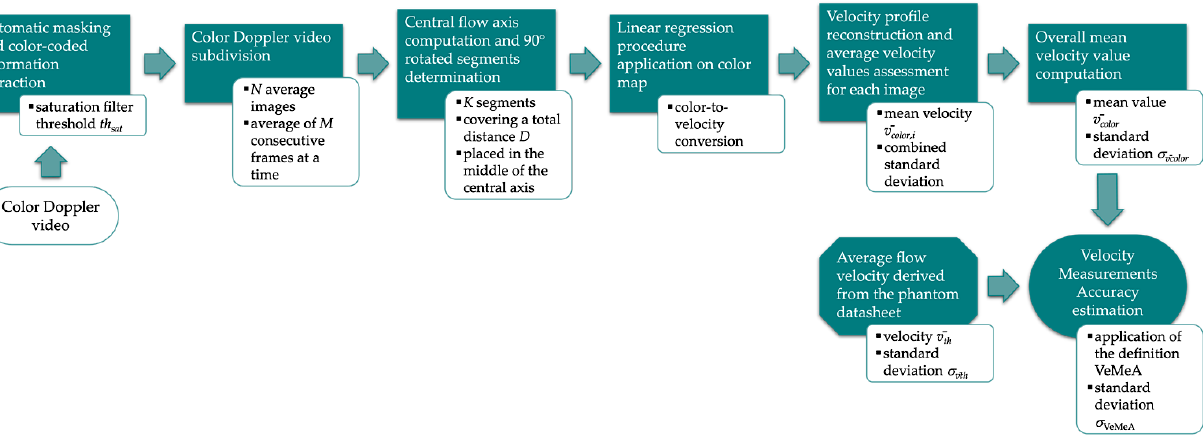
Figure 8. Flow chart of the image analysis-based method for VeMeA parameter estimation.